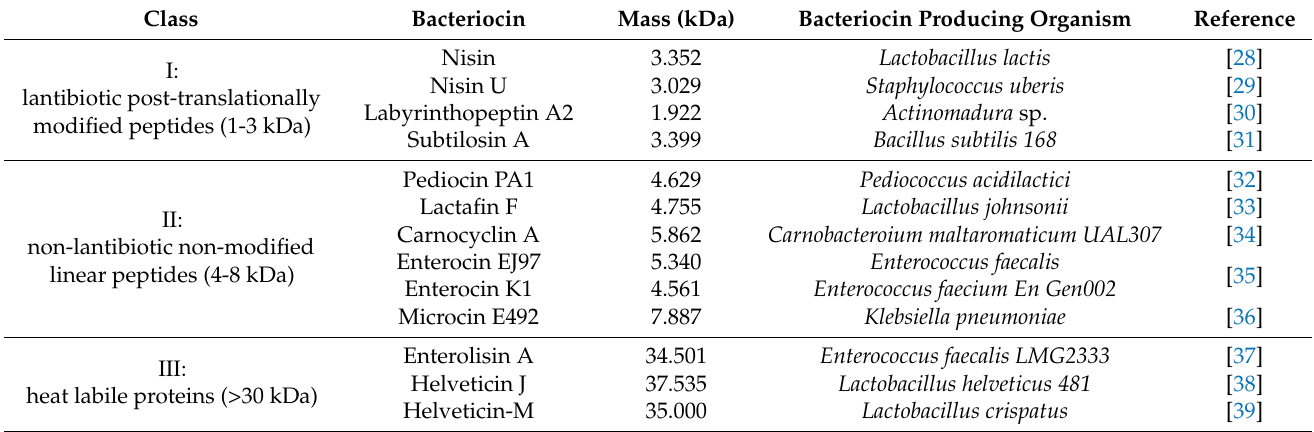
Table 1. Antimicrobial Peptide Classification